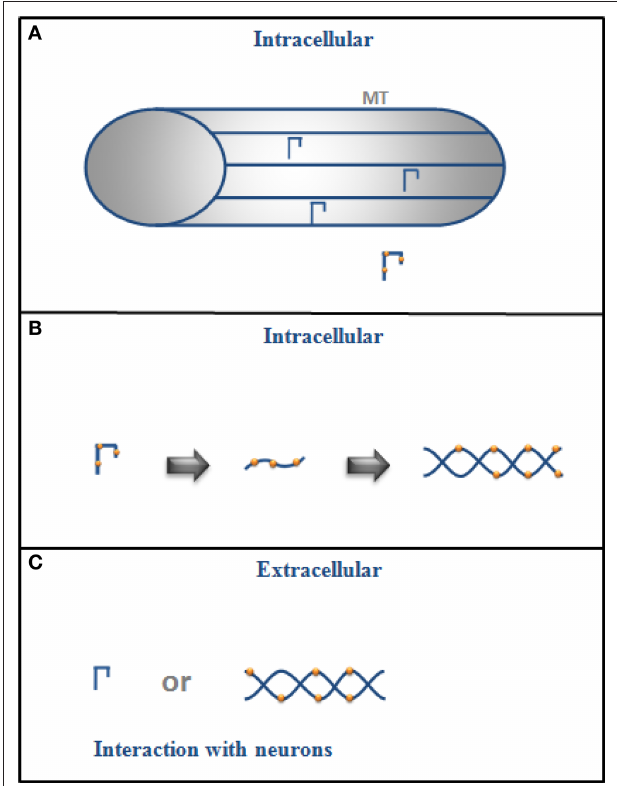
Figure 1 | (A) Intracellular tau is mainly bound to microtubules (MT) in the cytoplasm of a neuron but if it is phosphorylated (drawing with dots), its binding to MT decreases, and (B) it could also change its conformation and aggregate into filaments. (C) In its extracellular form, tau could exist as monomers or in filaments (aggregated form), and it could interact with